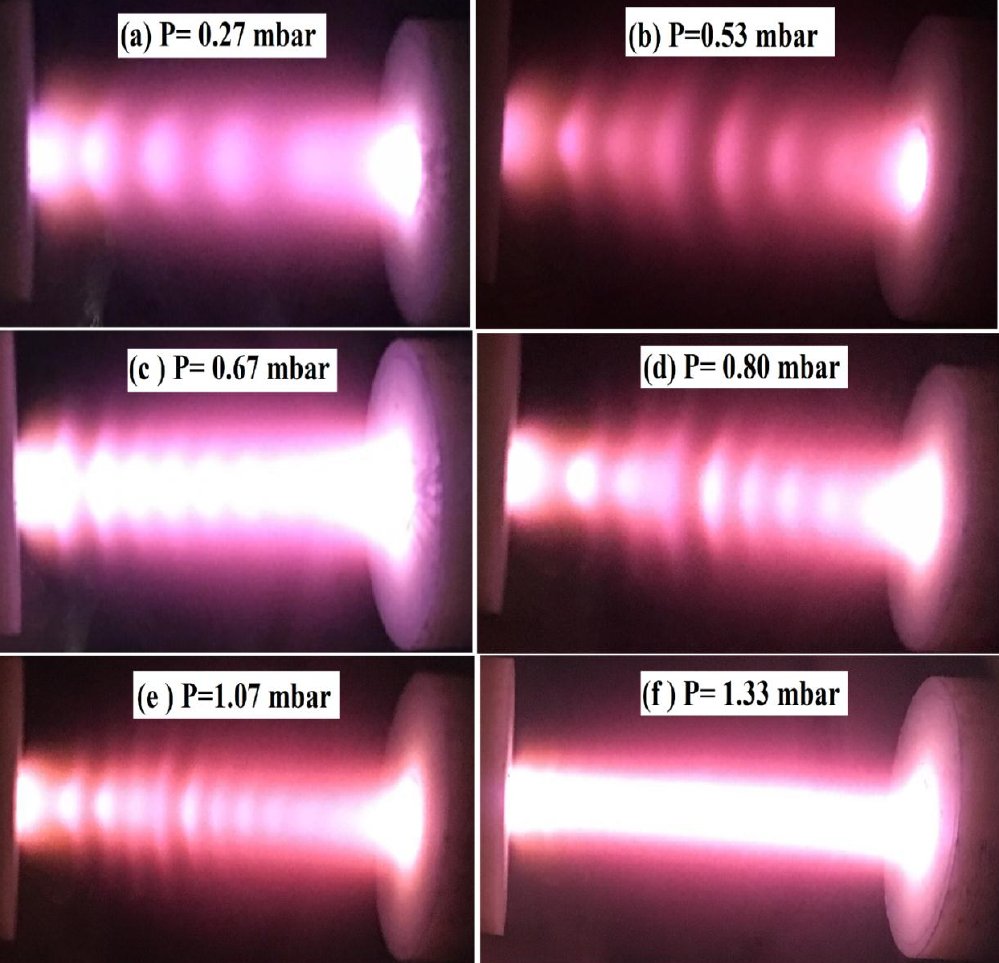
Fig. 4: Influence of Ar gas pressure on the glow discharge region in the hollow cathode system in the present of magnetic